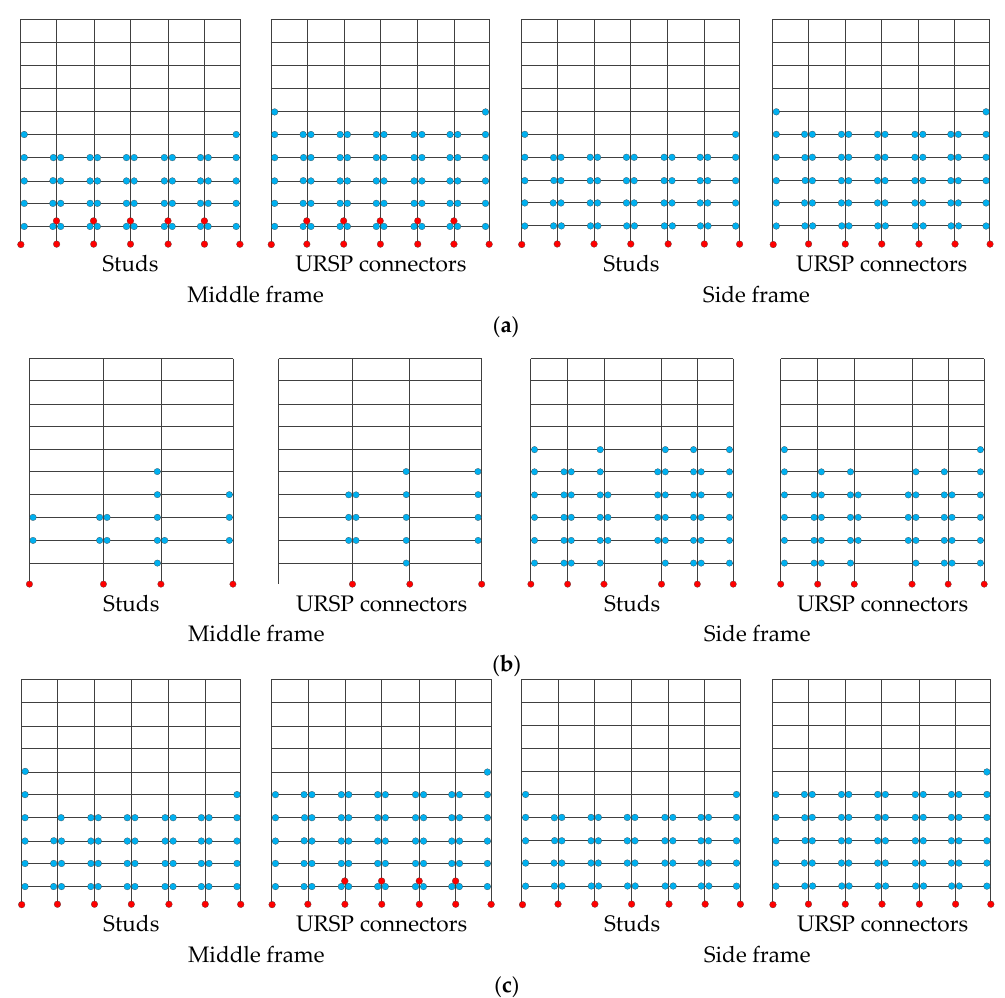
Figure 13. Distribution and failure modes of plastic hinges: ( a ) case XL1; ( b ) case YL1; ( c ) case XL2. Red and blue circular solid points represent the column and beam plastic hinges, respectively.